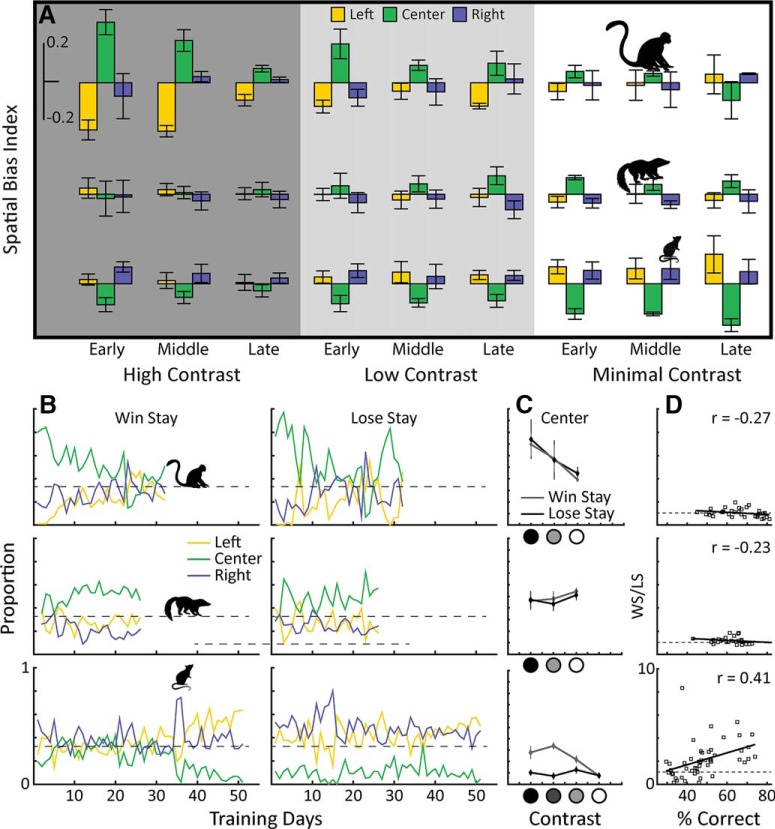
Behavioral strategy. A, The spatial bias index (see text) for the three species is shown for the three contrast conditions. B, The probability of remaining at the three response locations following a reward, or following no reward is shown for each species and training stage. C, The mean values for win stay and lose stay for the center position over the different contrast conditions are shown. D, Ratio of win stay/lose stay (WS/LS) versus behavioral performance at the center position for each of the species. Only for rats is WS/LS ratio correlated with behavioral performance, suggesting that they are able to sustain good behavioral performance using reward to counteract their spatial bias against the center nose poke.